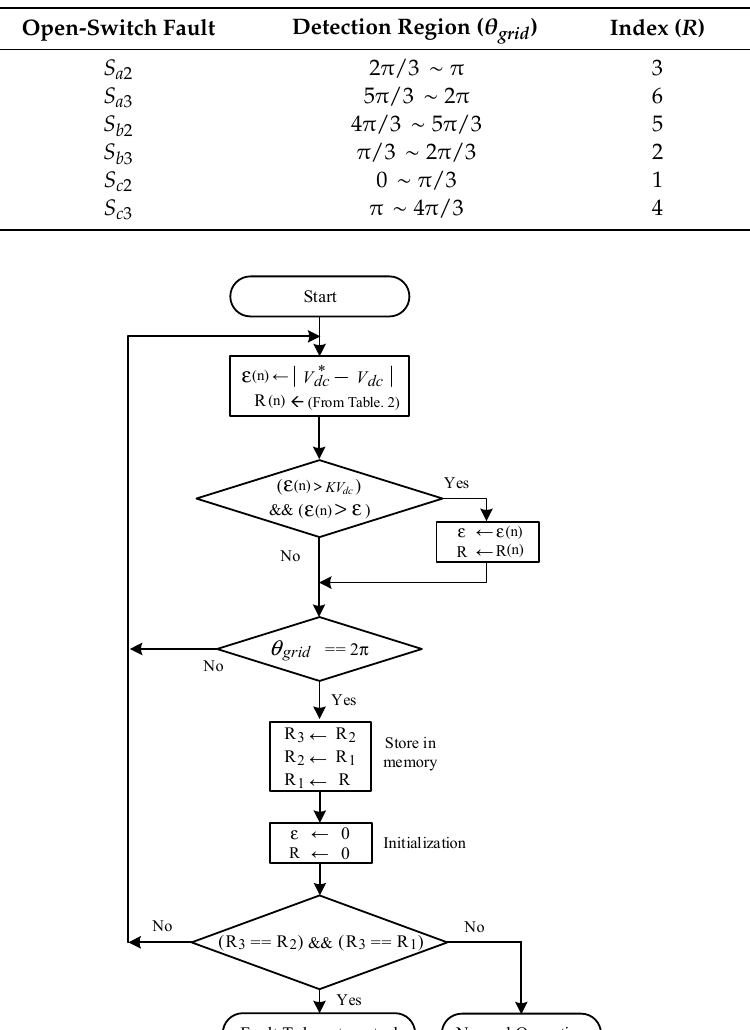
Figure 7. Flowchart of the proposed open-switch fault diagnosis algorithm.